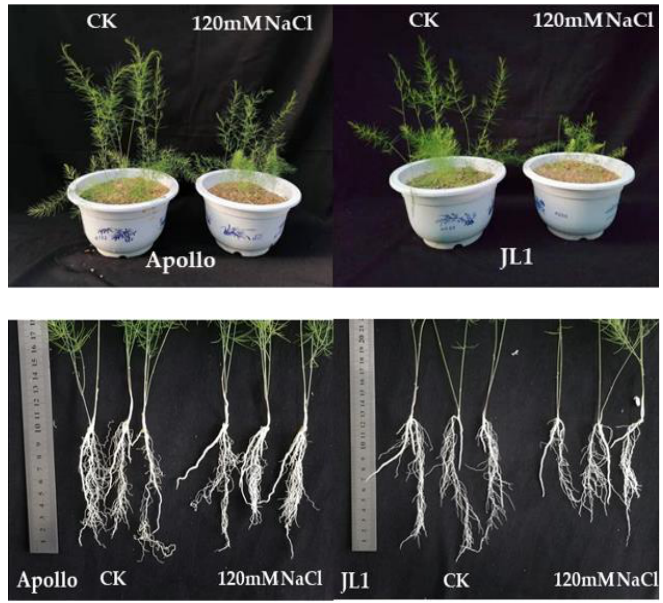
Figure 1. The phenotype of two asparagus cultivars under CK and salt stress.